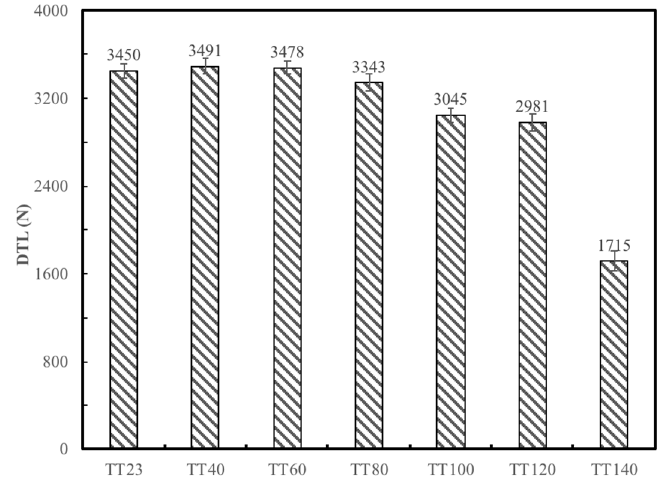
Figure 8. The DTL of FFRP laminates tested at different temperatures.